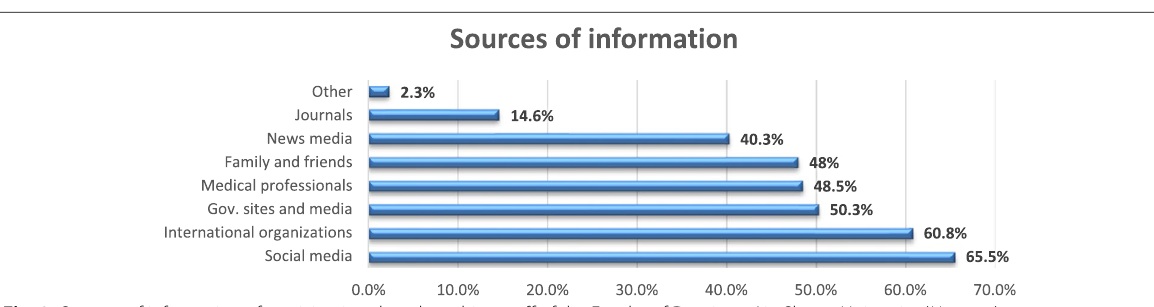
Fig. 2 Sources of information of participating dental teaching staff of the Faculty of Dentistry, Ain Shams University ( N